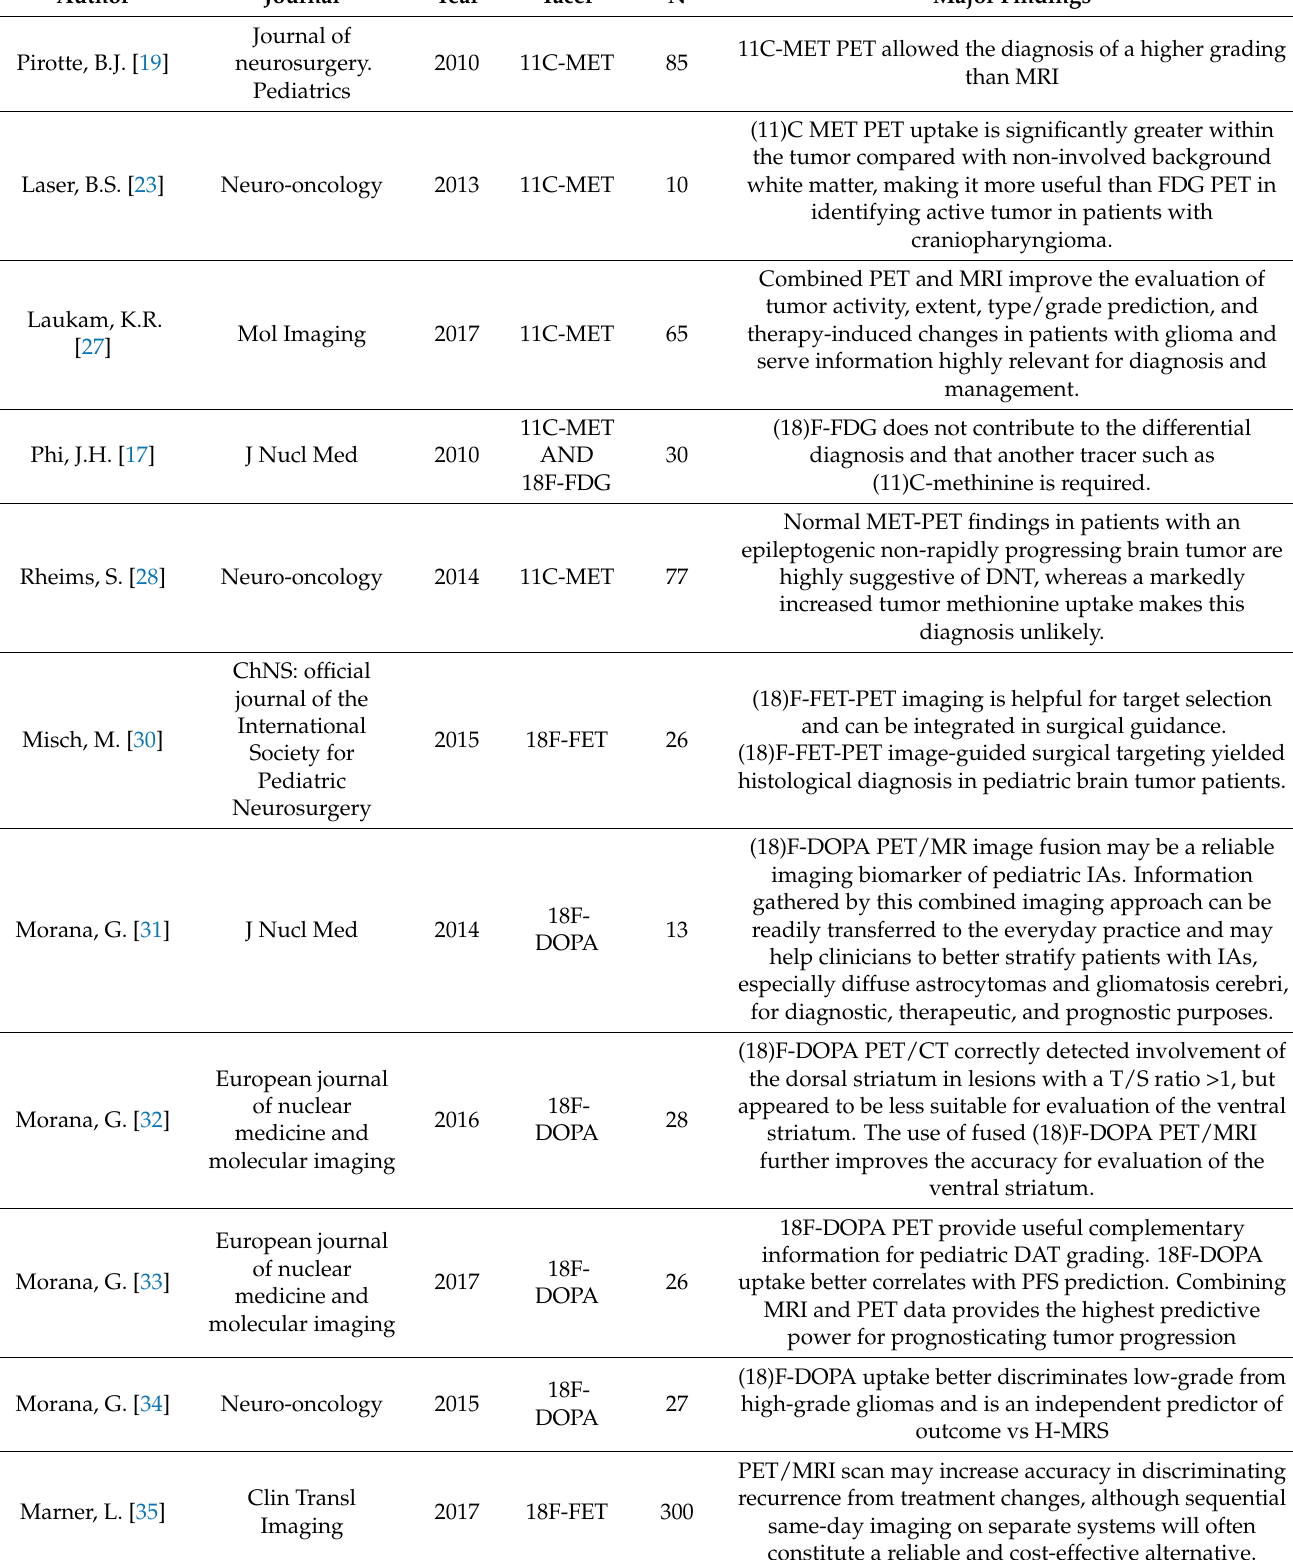
Table 3. Major findings of studies on non-FDG PET